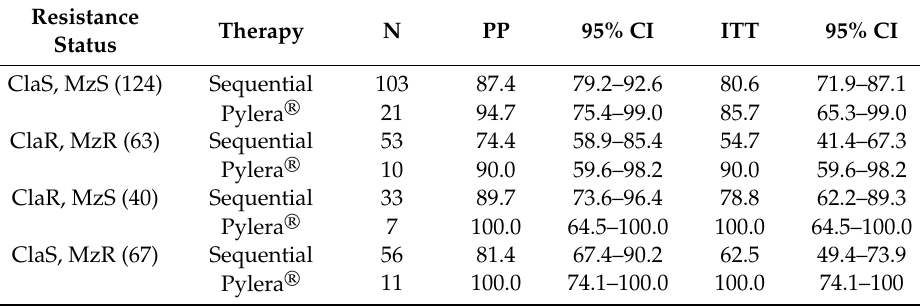
Table 4. Eradication rates according to the bacterial resistance pattern.